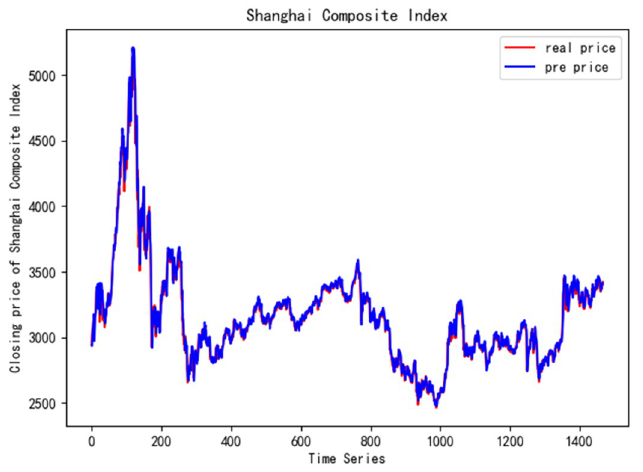
Fig 8. Closing price of Shanghai Composite Index.